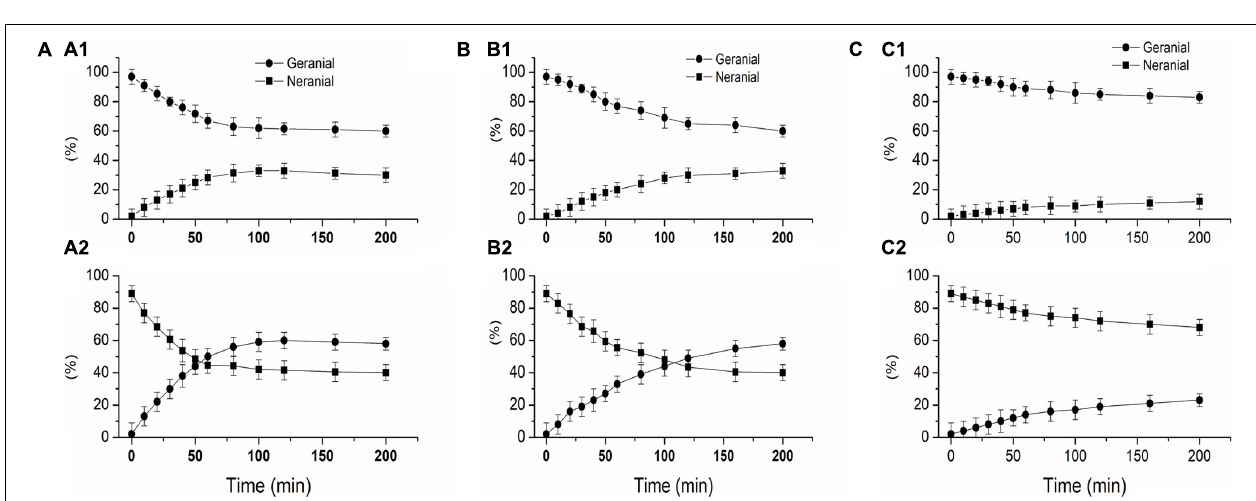
FIGURE 1 | Proposed pathway for the isomerization of geranial (1a) and neral (1b) and their conversion via 3-hydroxycitronellal (3) into methyl heptenone (6) and acetaldehyde (5), catalyzed by Soy Protein Isolate (SPI), in alkaline aqueous solution.